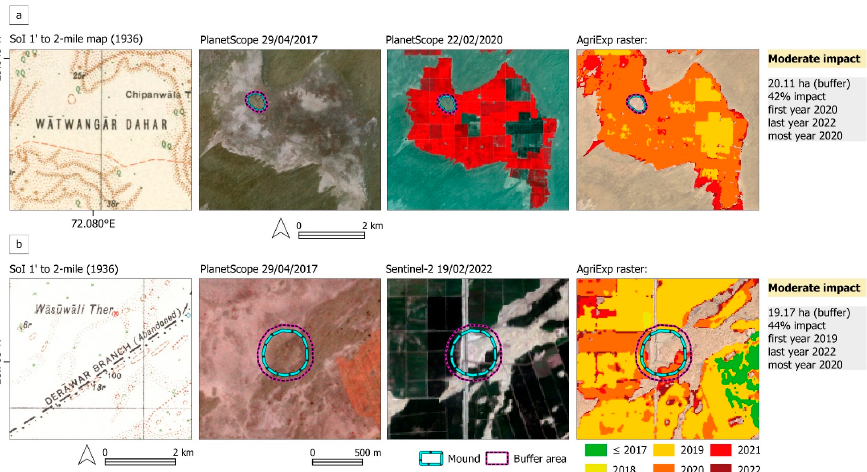
Figure 10. ( a ) Recent agricultural expansion into desert mudflats or dahars (2019–2020) has